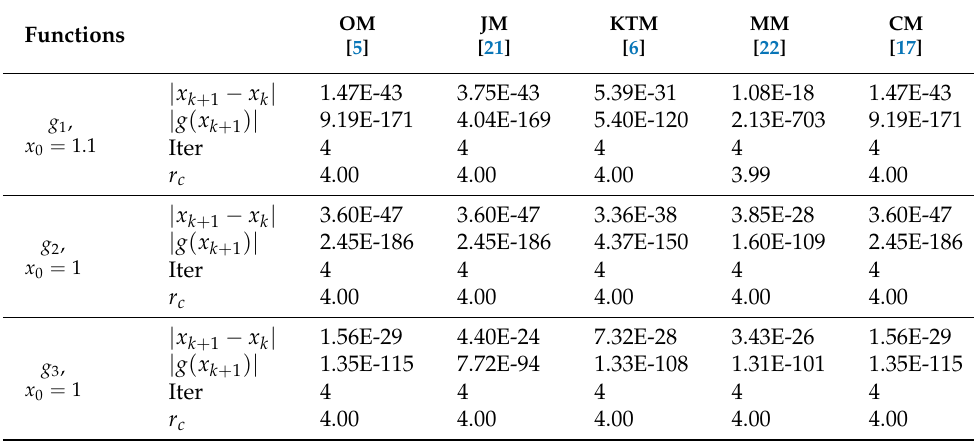
Table 1. Comparison of various iterative schemes (first part).